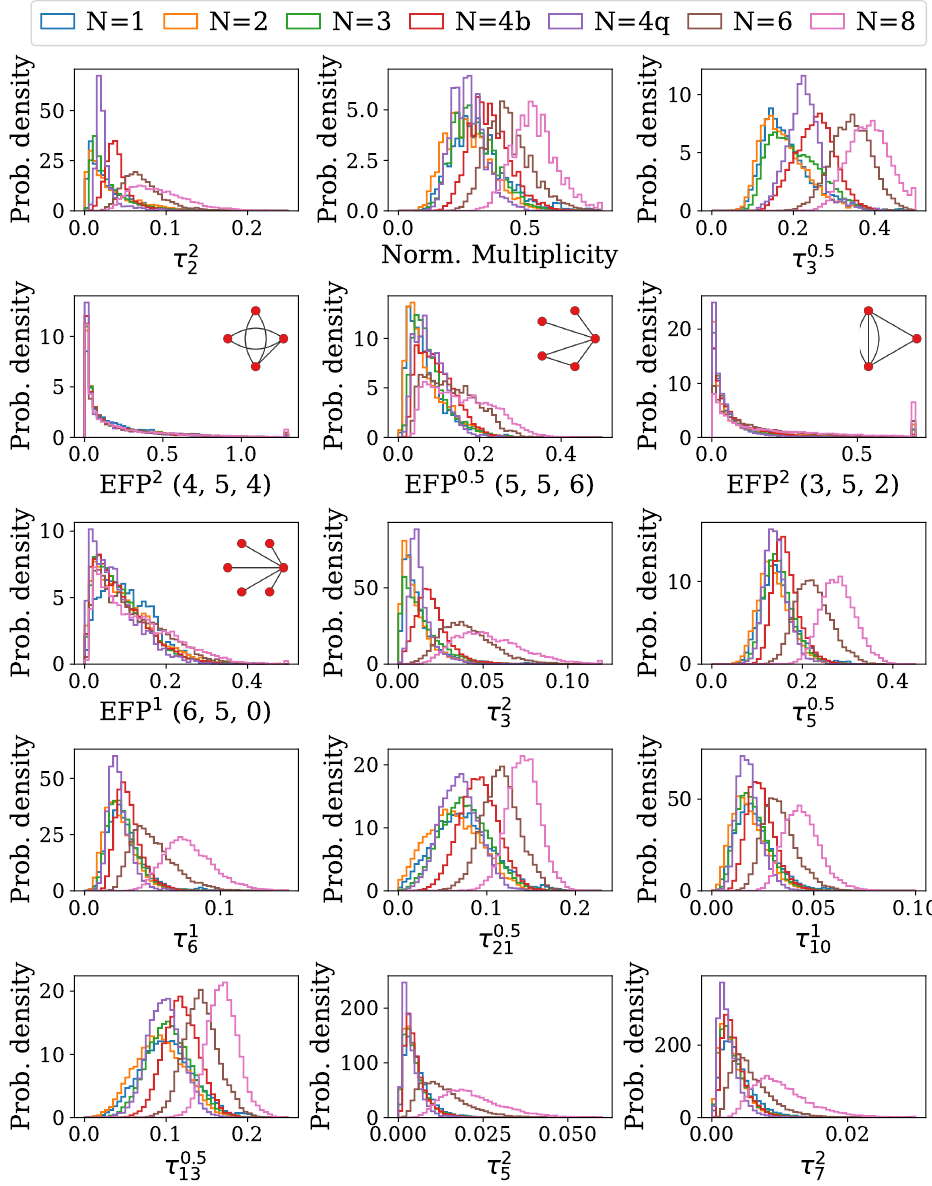
Figure 12 . Distributions of the second half of the most important LASSO-selected observables. The plots are ranked left-to-right top-to-bottom in order of importance according to the method described in section 6.3. For each EFP observable, the corresponding graph is also displayed for visualization purposes. The distributions of the rest of the LASSO-selected observables are shown in figure